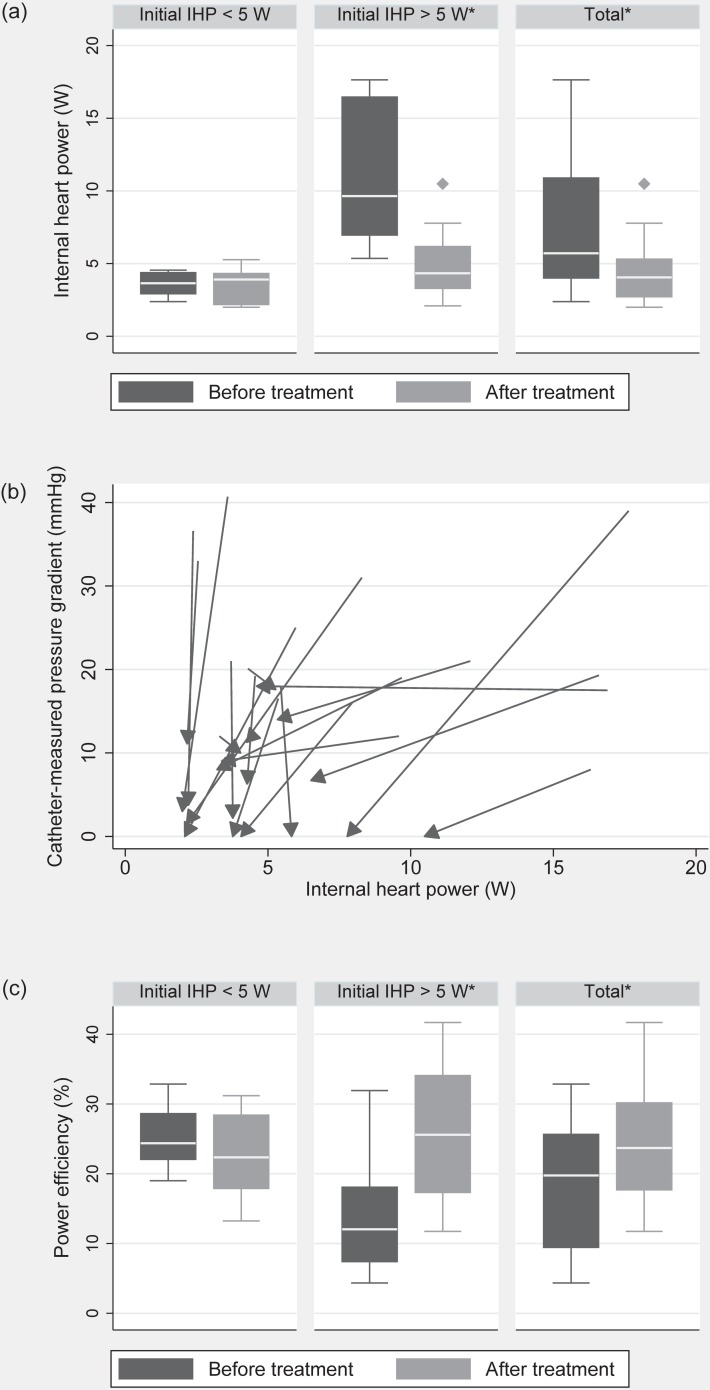
Main results.(a) Internal heart power (IHP) before and after treatment divided into groups according to the initial IHP above and below 5 W (b) The change in IHP with treatment plotted against the change of catheter-measured pressure gradients in each patient (the start-point of each vector represents the state before treatment, whereas the end-point represents the state after treatment) (c) Power efficiency before and after treatment grouped according to the initial IHP. * statistically significant differences.